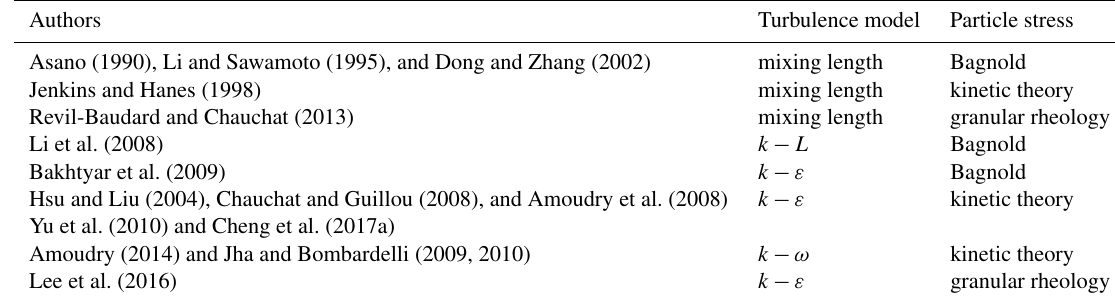
Table 1. Summary of Eulerian two-phase models for sediment transport applications. Authors Turbulence model Particle stress Asano (1990), Li and Sawamoto (1995), and Dong and Zhang (2002) mixing length Bagnold Jenkins and Hanes (1998) mixing length kinetic theory Revil-Baudard and Chauchat (2013) mixing length granular rheology k − L Bagnold Bakhtyar et al. (2009) k − ε Bagnold Hsu and Liu (2004), Chauchat and Guillou (2008), and Amoudry et al. (2008) k − ε Yu et al. (2010) and Cheng et al.